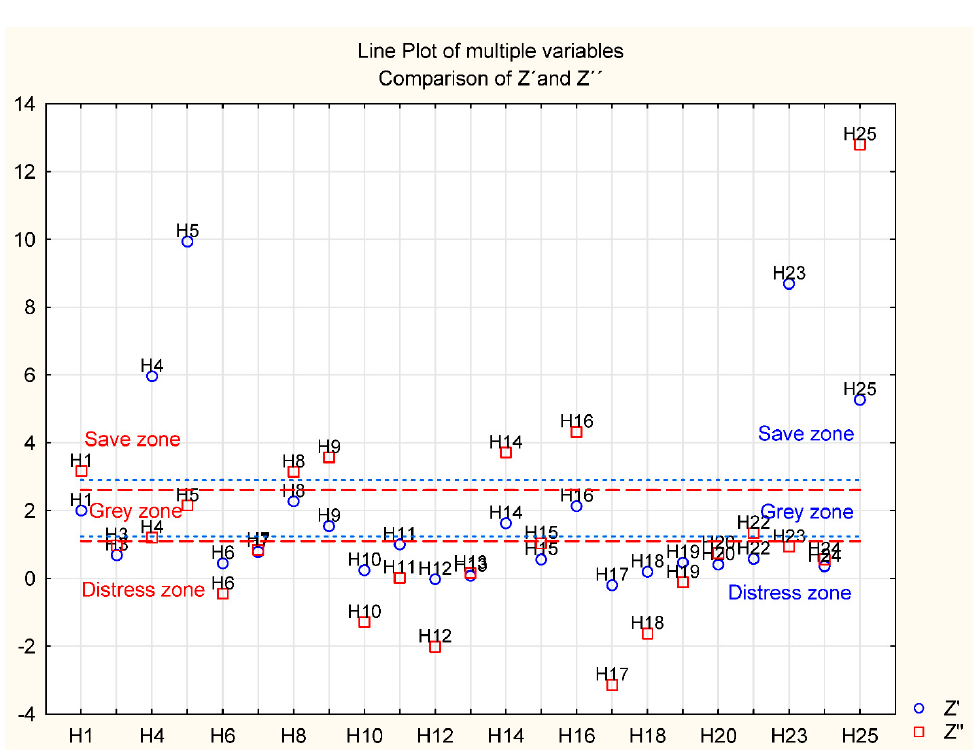
Figure 5. The comparison of Z’ and Z”.